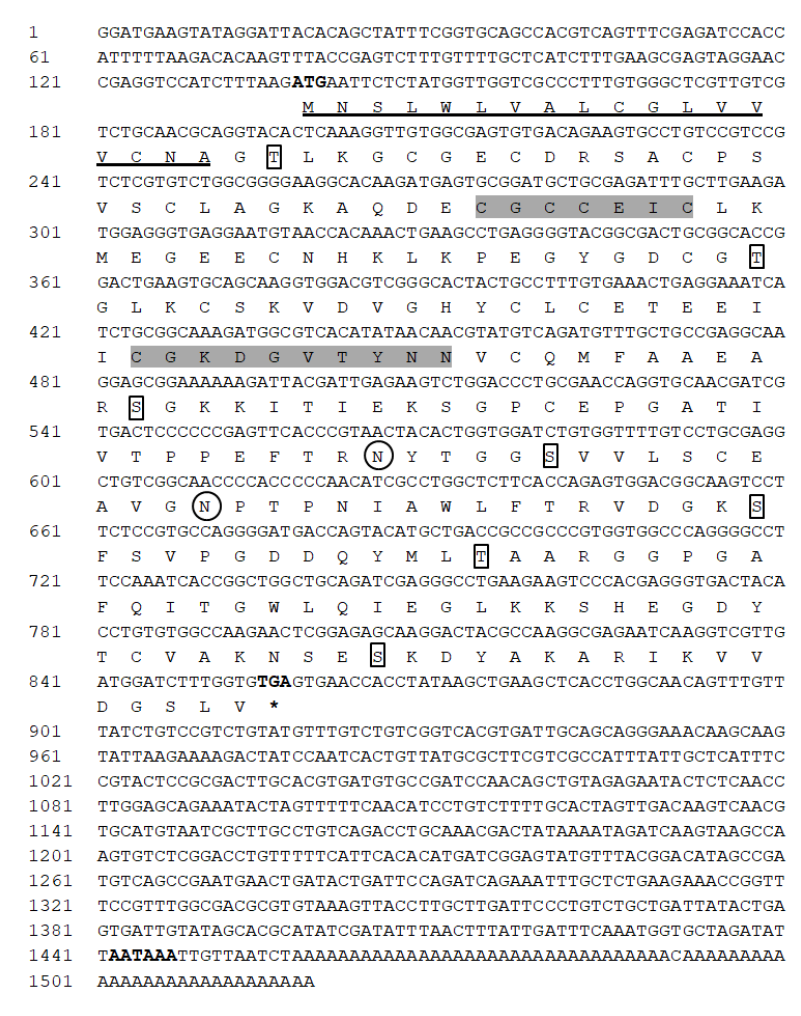
Figure 1. The full-length nucleotide and deduced amino acid sequences of Hdh IGFBP7. The initiation codon, termination codon (asterisks) and putative polyadenylation signal sequence are marked in boldface. The N-linked glycosylation site is circled. Phosphorylation sites are boxed. The signal peptide is underlined. Characteristic conserved motifs “XCGCCXXC” and “CGXDXXTYXN” are highlighted in light grey.